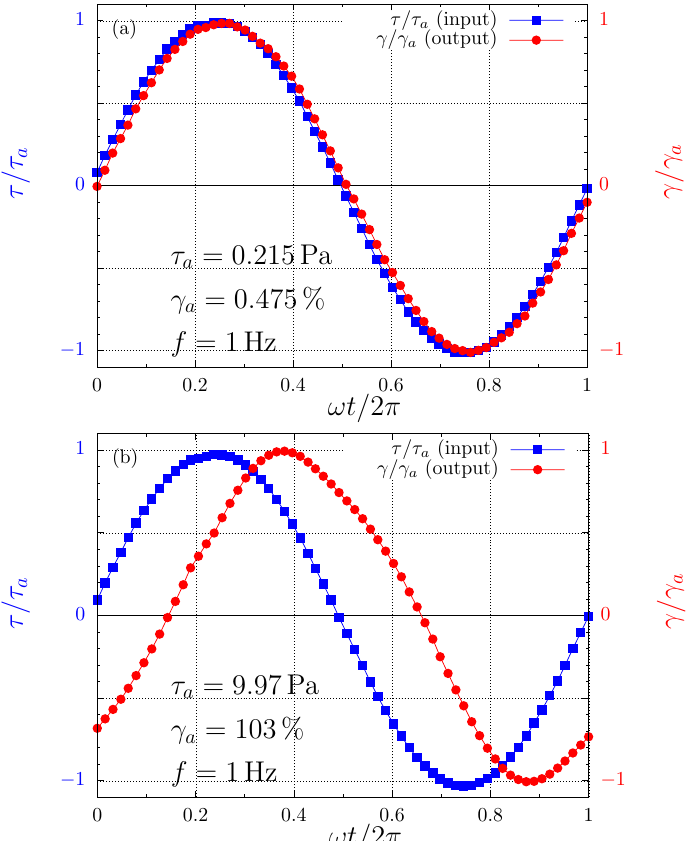
Figure 2. The input and output waves for two different stress amplitudes. ( a ) τ a = 0.215Pa [in the linear viscoelastic region (LVR)]; and ( b ) τ a = 9.97Pa (in the yielding